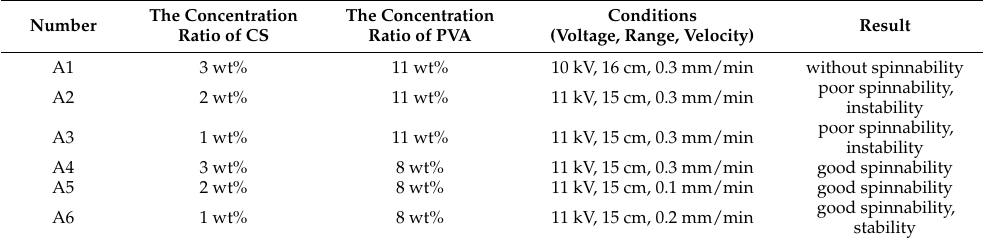
Table 1. Spinning effect of CS/PVA spinning solution with different